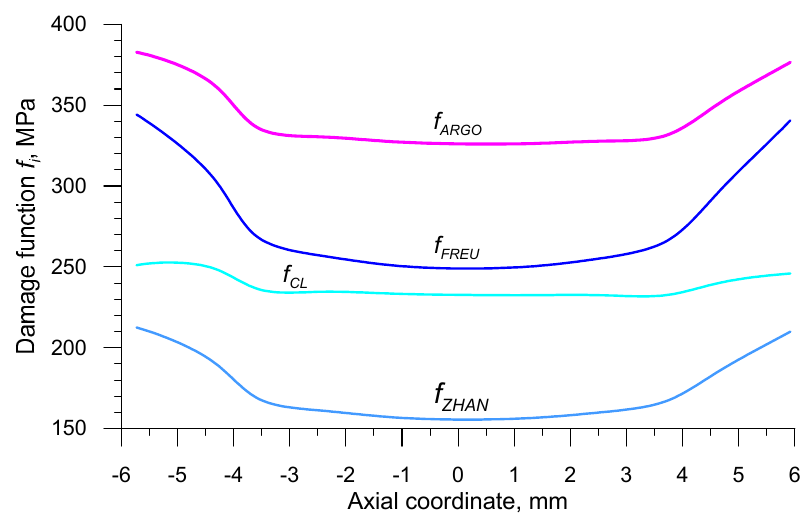
Figure 13. Distributions of the stress damage functions in the axis of the sample subjected to rotational compression in a channel at s = 700 mm and T = 1150 °C.